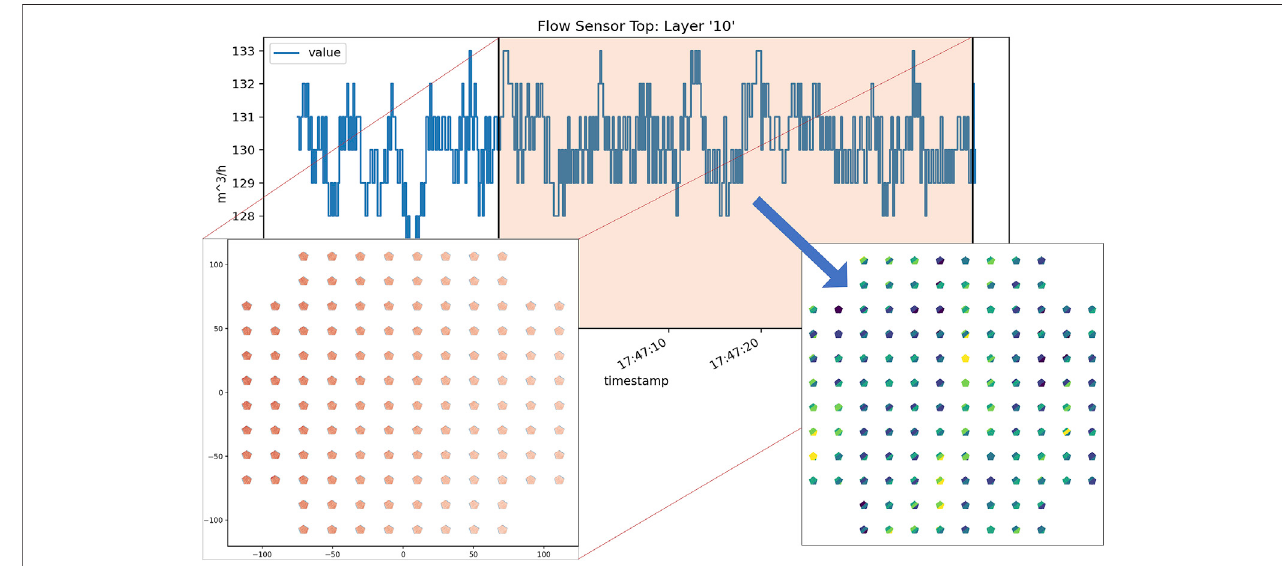
FIGURE 6 | 3D plot of the build volume of spatially mapped process data for “ Residual oxygen value in gas loop ” with defects overlaid for build 2. Note that this image shows combined soot and debris defects (Scime et al., 2020), but for the actual analysis only soot was considered.